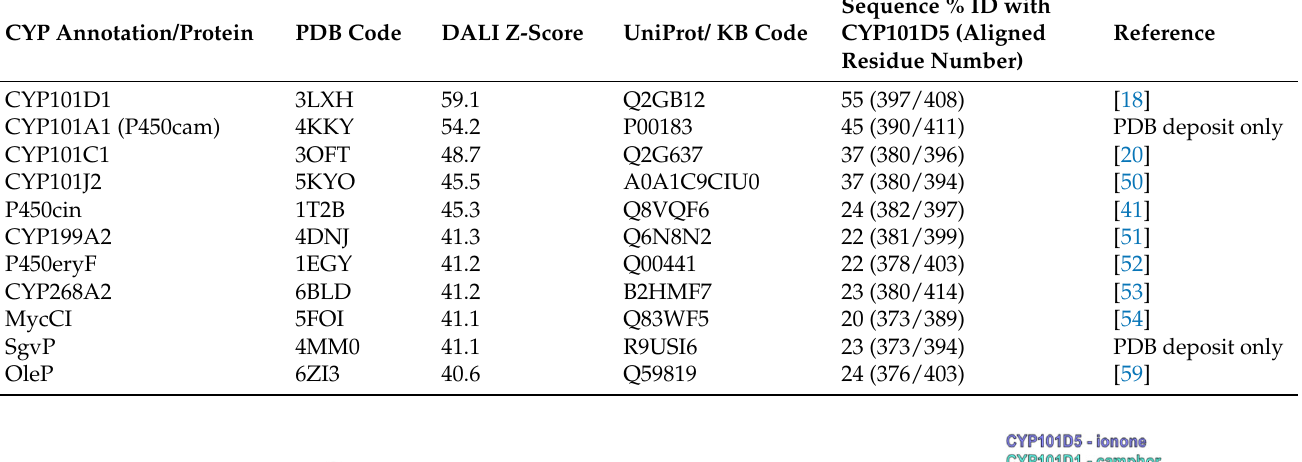
Table 4. Structural homologue search results for CYP101D5 from a DALI search (DALI-Lite server).